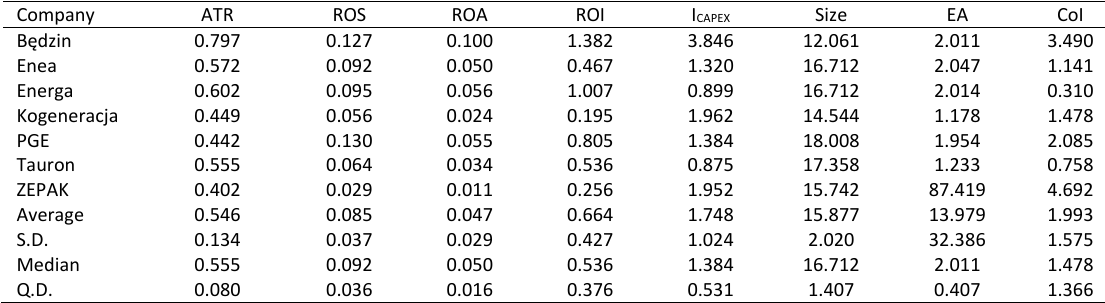
Table 3: Financial and environmental ratios for Polish energy groups in 2014